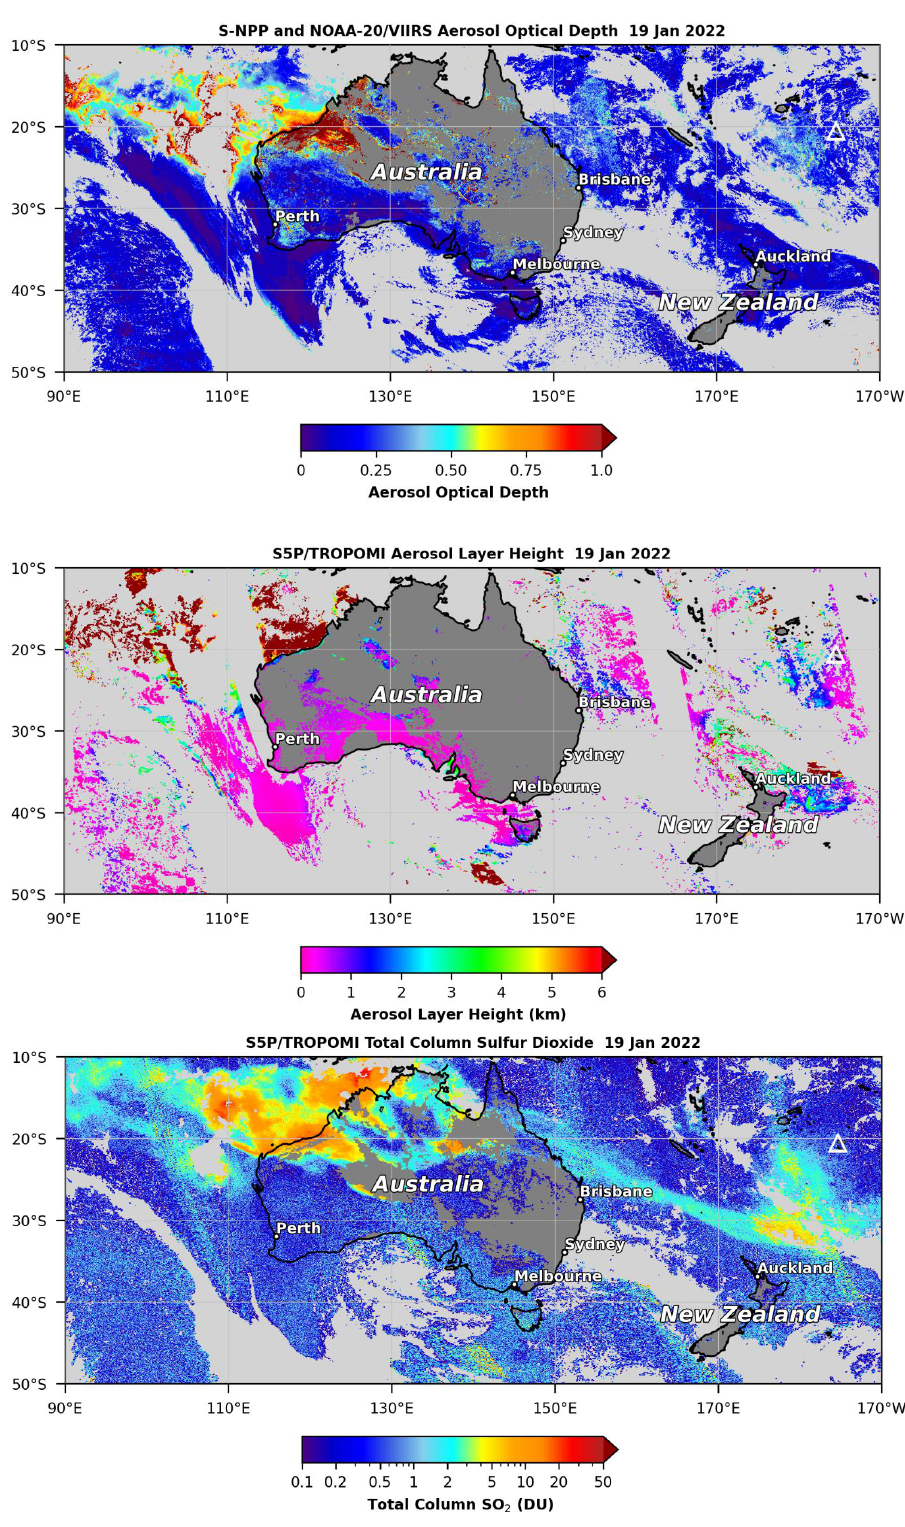
Figure 9. Composite VIIRS aerosol optical depth (AOD) from the S-NPP and NOAA-20 satellites (upper), Sentinel-5 Precursor TROPOMI aerosol layer height (ALH) (middle), and TROPOMI SO 2 (lower), showing an example of the westward progression of volcanic aerosols (AOD ≥ 0.5, ALH ≥ 6 km) reaching northwestern Australia and the northern Indian Ocean on January 19, 2022. The small triangle represents the approximate location of the Hunga-Tonga volcano.